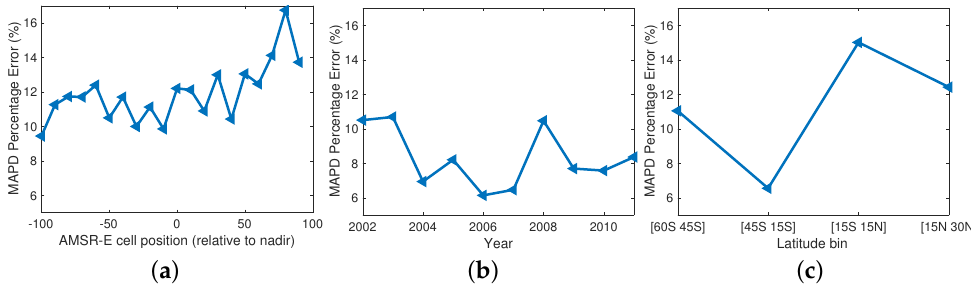
Figure 13. MAPD Percentage deviation for ( a ) across-track, ( b ) year-by-year and ( c ) latitude-based footprint